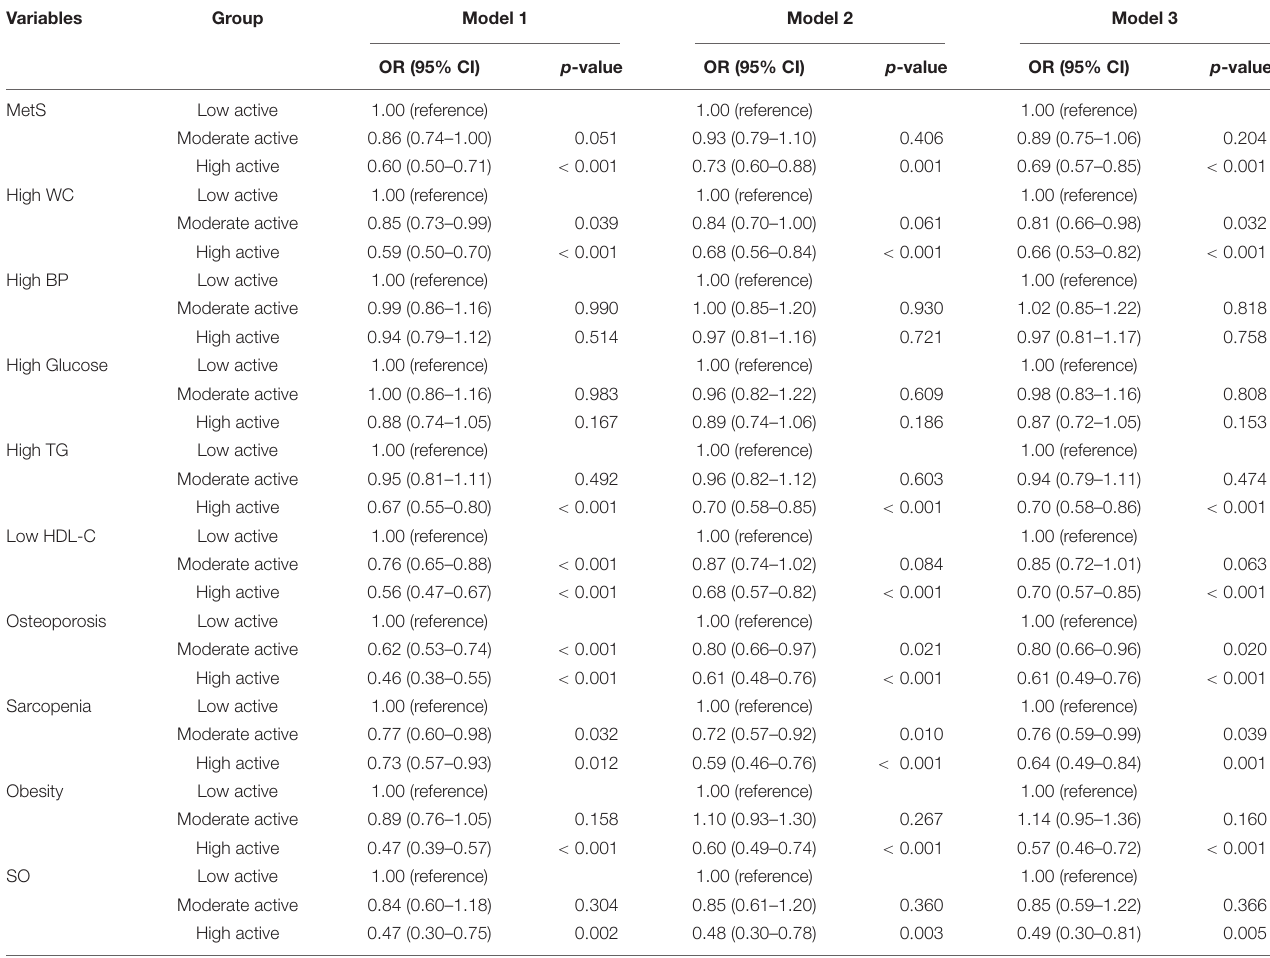
TABLE 4 | Odds ratio (95% CI) for sarcopenia and cardiometabolic risk factors according to physical activity levels. Variables